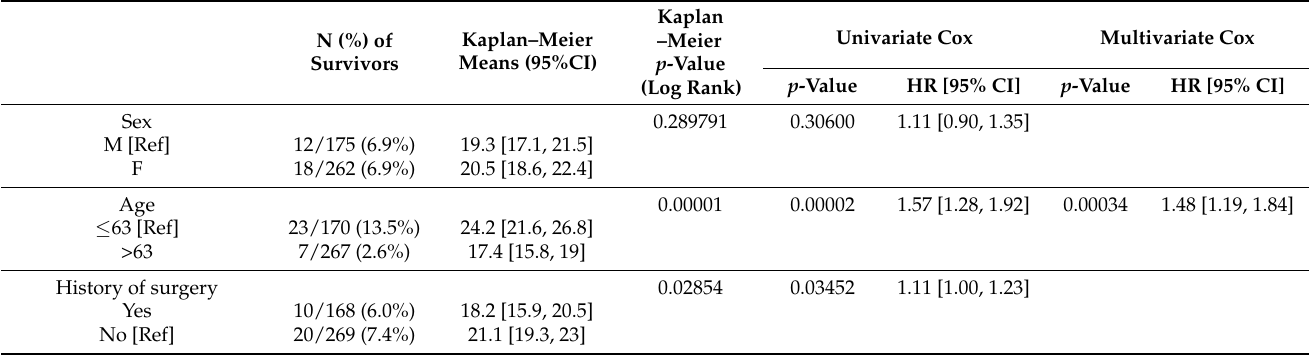
Table 3. Kaplan–Meier survival analysis and Cox regression